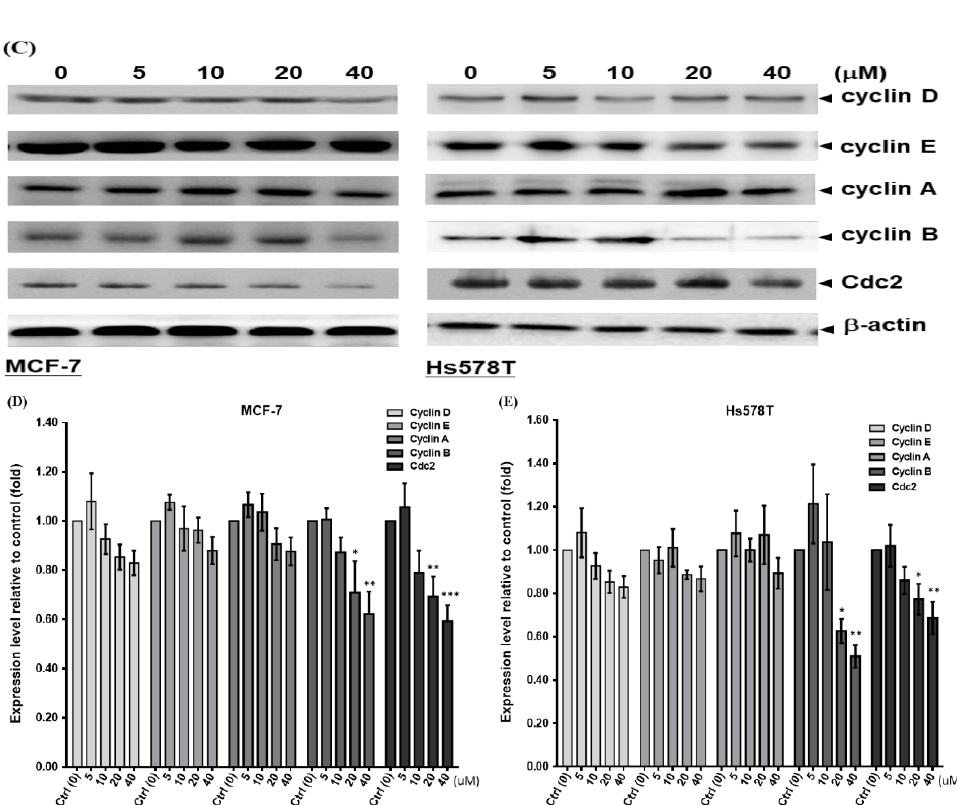
Figure 2. Effect of diosgenin on the induction of G2/M phase arrest in breast cancer cells. ( A ) Distribution of MCF-7 and Hs578T cells across each phase of the cell cycle as determined by flow cytometric analysis of the percentages of cells with specific DNA contents determined by propidium iodide staining. ( B ) MCF-7 and Hs578T cells were cultured in the absence or presence of the indicated concentrations of diosgenin for 48 h. Percentages of cells at different stages of the cell cycle are shown as means ± SD from three independent experiments. * p < 0.05, ** p < 0.01, and *** p < 0.001 vs. control (Ctrl, 0 µM) cells. ( C ) Diosgenin induces G2/M phase arrest in MCF-7 and Hs578T cells after diosgenin treatment (0 – 40 µM) for 48 h. ( D , E ) Protein levels were determined by Western blot analyses using specific antibodies to the indicated cell cyclins. β -actin was used to normalize the amount of protein in each lane. Data are presented as the mean ± SD from three independent experiments. * p < 0.05, ** p < 0.01, and *** p < 0.001.